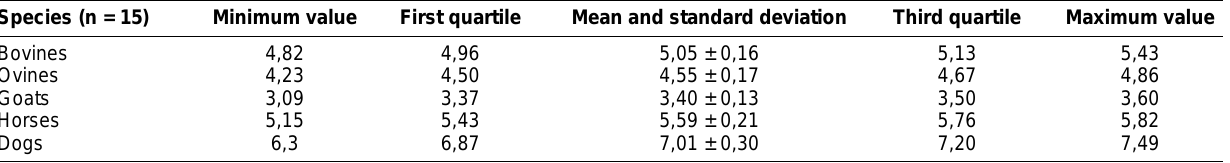
Table-1. Terminal values, averages, standard deviation and quartiles of the diameter of red blood cells of pets (expressed in µm).